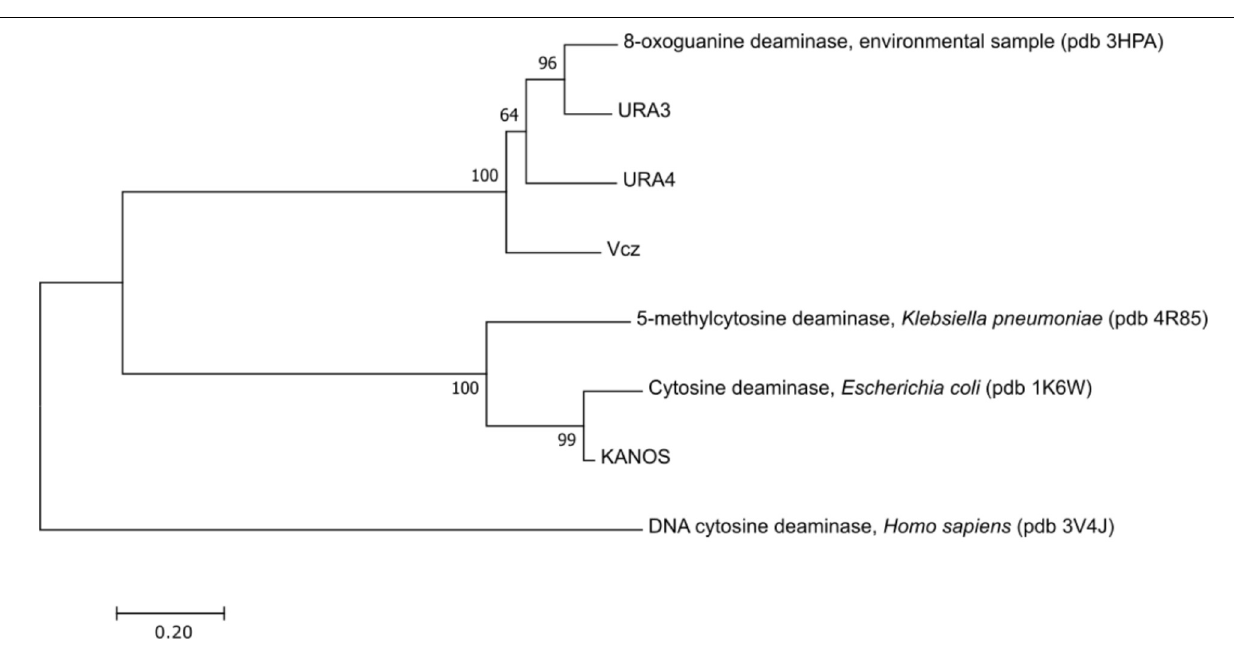
Frontiers in Microbiology |